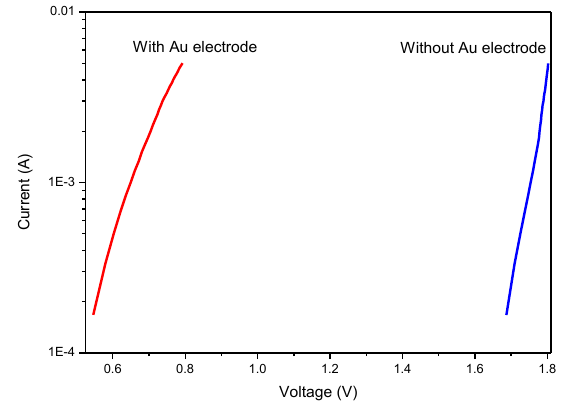
Figure 11. I–V curves of single layer WO 3 with or without gold electrode.